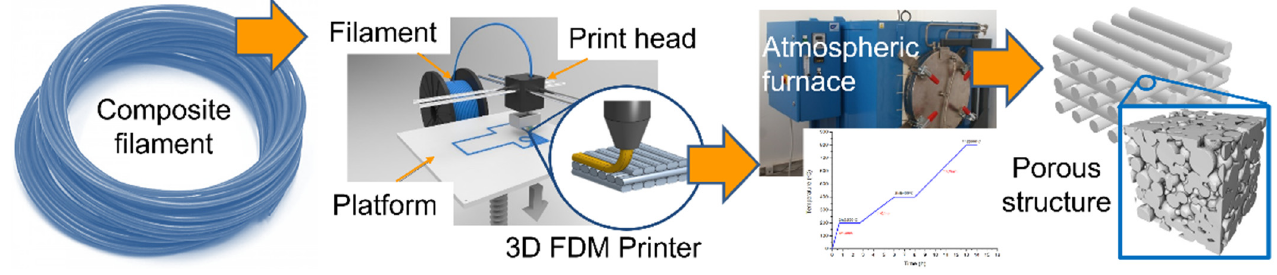
Figure 3. Fabrication of open porous materials by application of 3D printing.